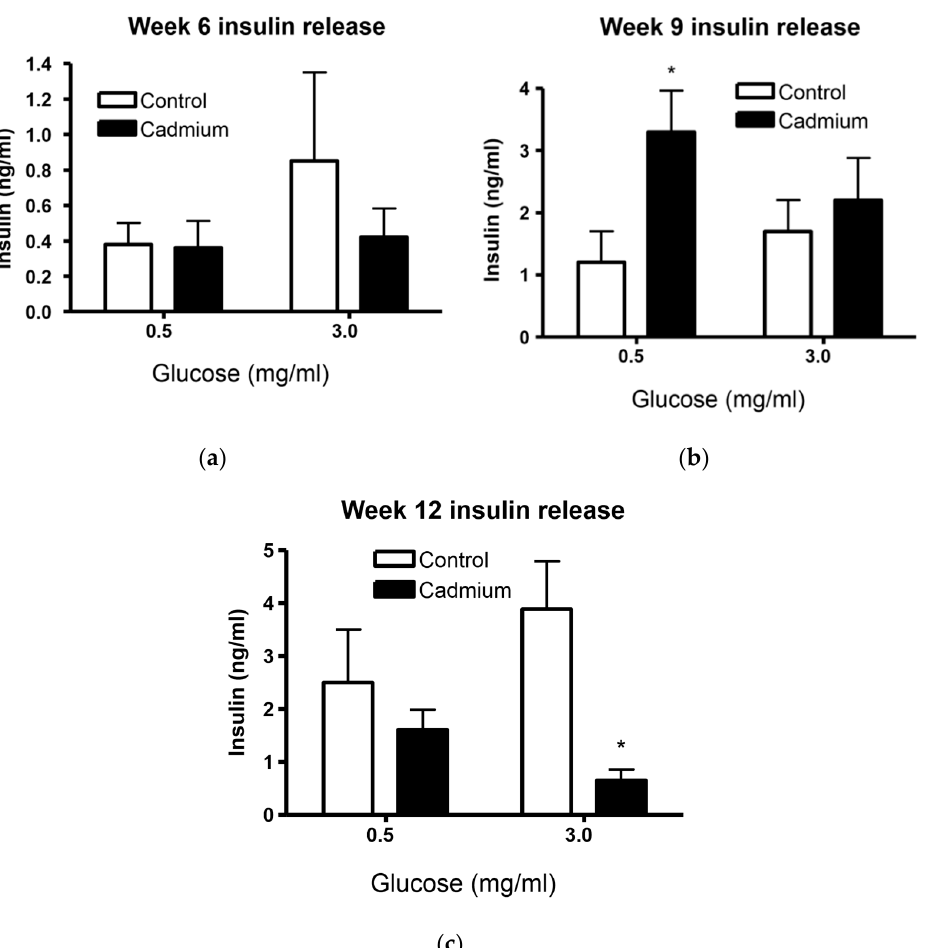
Figure 3. Data show changes in insulin release in freshly isolated islets from week ‐ matched control animals and Cd ‐ treated (0.6 mg/kg/day) animals after 6 ( a ), 9 ( b ), and 12 weeks ( c ). An asterisk (*) denotes significant treatment differences from islets incubated in the same glucose concentrations 0.5 mg/mL (week 9) or 3.0 mg/mL (week 12) (one ‐ way ANOVA and Tukey’s post tests, p ≤ 0.05, n = 0.5 mg/mL (week 9) or 3.0 mg/mL (week 12) (one-way ANOVA and Tukey’s post tests, p ≤ 0.05, 3–8 for each data point). n = 3–8 for each data